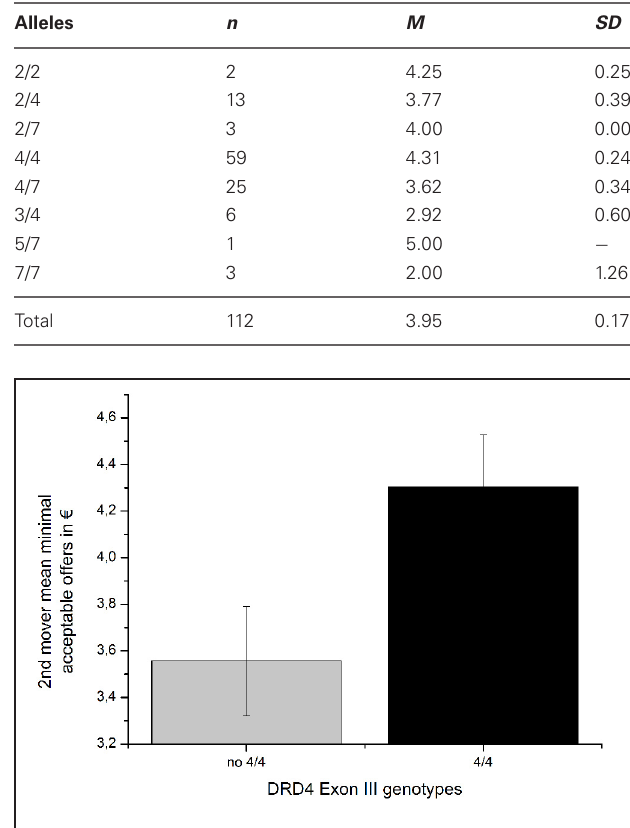
FIGURE 1 | Second-mover-behavior in the UG minimal acceptable offers in €, mean and SEM.